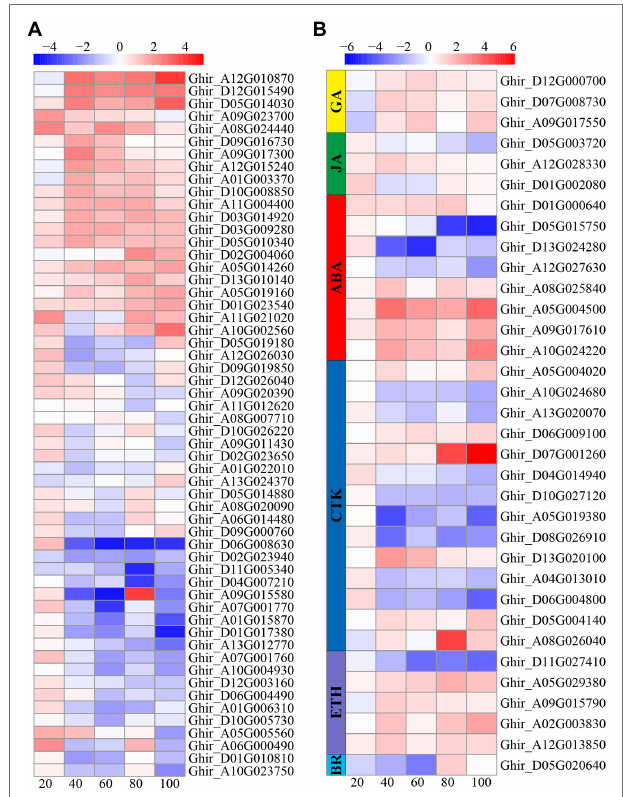
FIGURE 7 | Heatmap illustrating differential expression of auxin (A) , gibberellic acid (GA), jasmonic acid (JA), ABA, cytokinein (CTK), ethylene (ETH), and brassinolide (BR; B ) at 20, 40, 60, 80, and 100 days after emergence. Different scale color represents the size of log 2 fold change